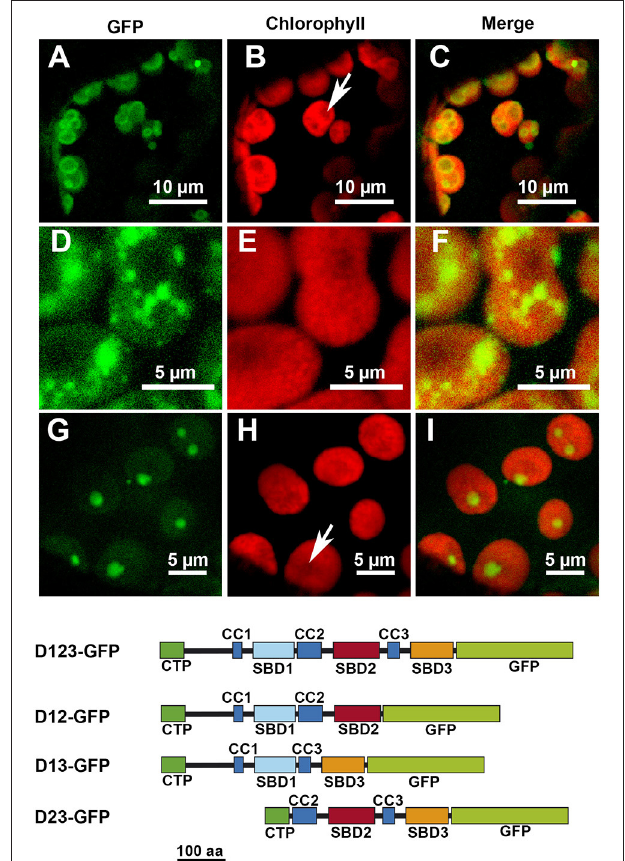
FIGURE 3 | Localization of different truncated versions of AtSS3 fused to GFP in N. benthamiana chloroplasts. D12-GFP: (A–C) . D13-GFP: (D–F) . D23-GFP: (G–I) . GFP column: fluorescence of the GFP marker. Chlorophyll column: autofluorescence of the chlorophyll. Merge column: merged images of previous columns. Bottom: structures of the constructs fused to GFP. D12-GFP: N-terminal region of AtSS3 without D3 fused to GFP. D13-GFP: N-terminal region of AtSS3 without D2 fused to GFP. D23-GFP: N-terminal region of AtSS3 without D1 fused to GFP. The white arrows indicate the presence of a starch